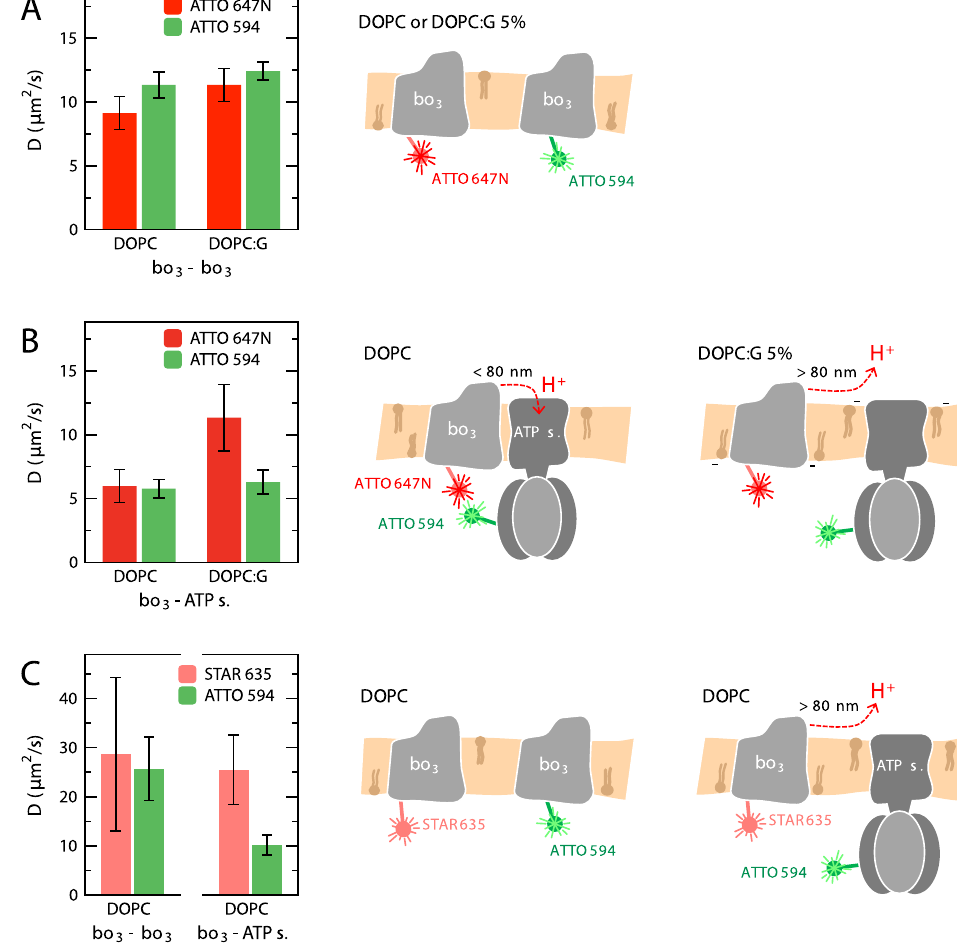
Figure 4. Diffusion coefficients determined from measurements of lateral diffusion of co-reconstituted proteins. ( A ) GUVs containing two populations of cyt. bo 3 , each labeled with either ATTO 647N or ATTO 594. The lipid composition was 99% DOPC or 94% DOPC and 5% DOPG (DOPC:G), and in addition 1% DPPE functionalized with a biotinyl head group. ( B ) Cyt. bo 3 labeled with ATTO 647N and ATP-synthase labeled with ATTO 594. ( C ) Left: GUVs composed of DOPC with two populations of cyt. bo 3 labeled with either Abberior STAR 635 or ATTO 594 ( bo 3 - bo 3 ). Right: GUVs composed of DOPC with cyt. bo 3 labeled with Abberior STAR 635 and ATP-synthase labeled with ATTO 594 ( bo 3 -ATP s.). Schemes to the right illustrate the conditions of the experiments and the conclusions (see text for details); ATTO 647N promotes the binding between cyt. bo 3 and ATP synthase in DOPC membranes but not in DOPC:G membranes, reflected in the apparent diffusion constants of cyt. bo 3 ( B ). The effect is not observed with only cyt. bo 3 in the membrane ( A ) or when ATTO 647N is replaced by the more hydrophilic Abberior STAR 635 ( C ). Measurements were done at pH 7.4 in 10 mM HEPES supplemented with 10 mM NaCl and 100 mM glucose. Error bars represent standard deviation from measurements with five